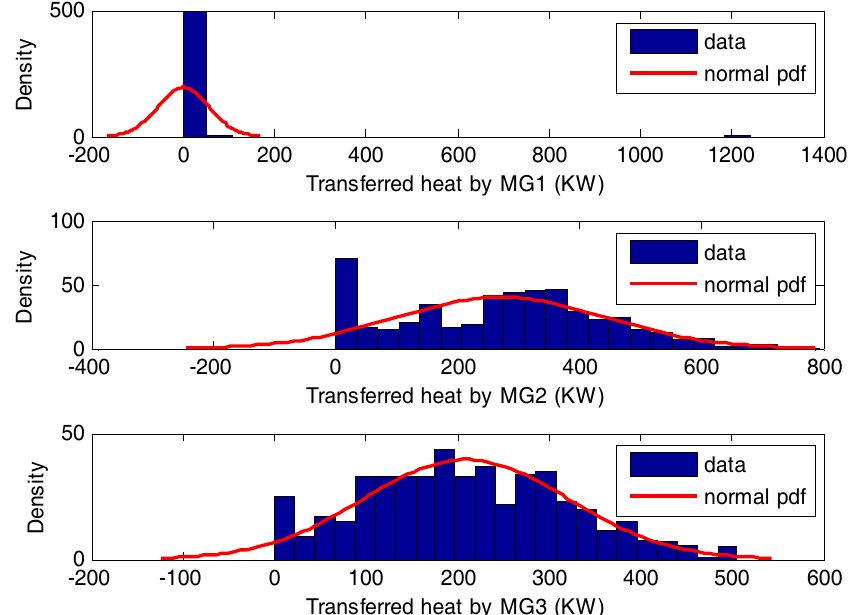
Figure 8. PDF of transferred heat by each MCMG. Top: MCMG1; Middle: MCMG2, Bottom: MCMG3.